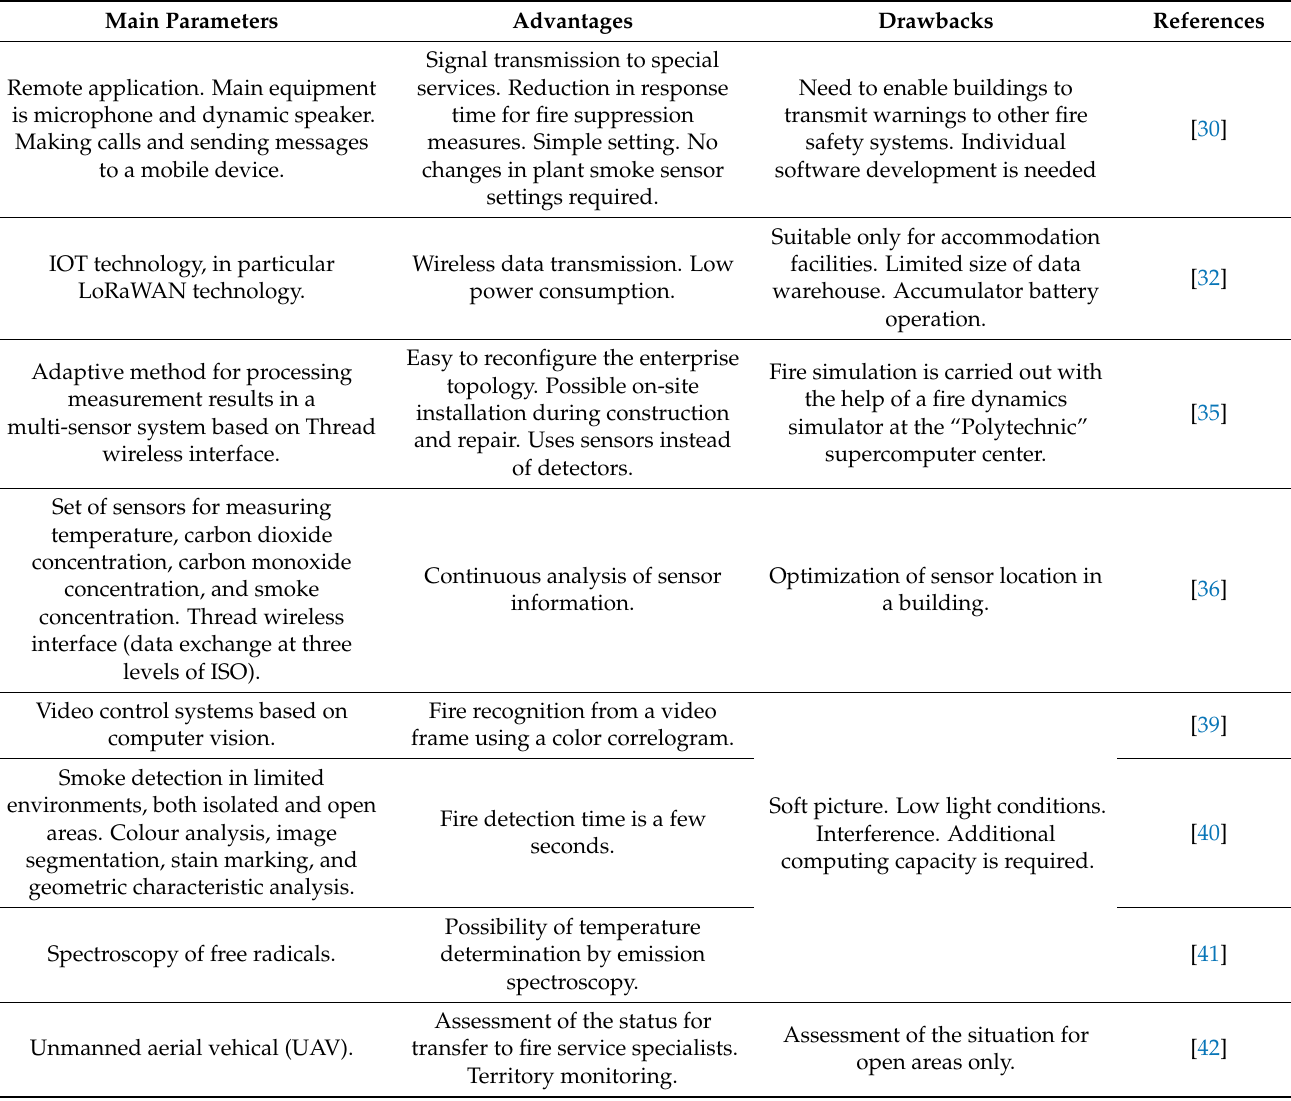
Table 1. The advantages and drawbacks of the systems regarding the new challenges of technology communication, IoT, and AI